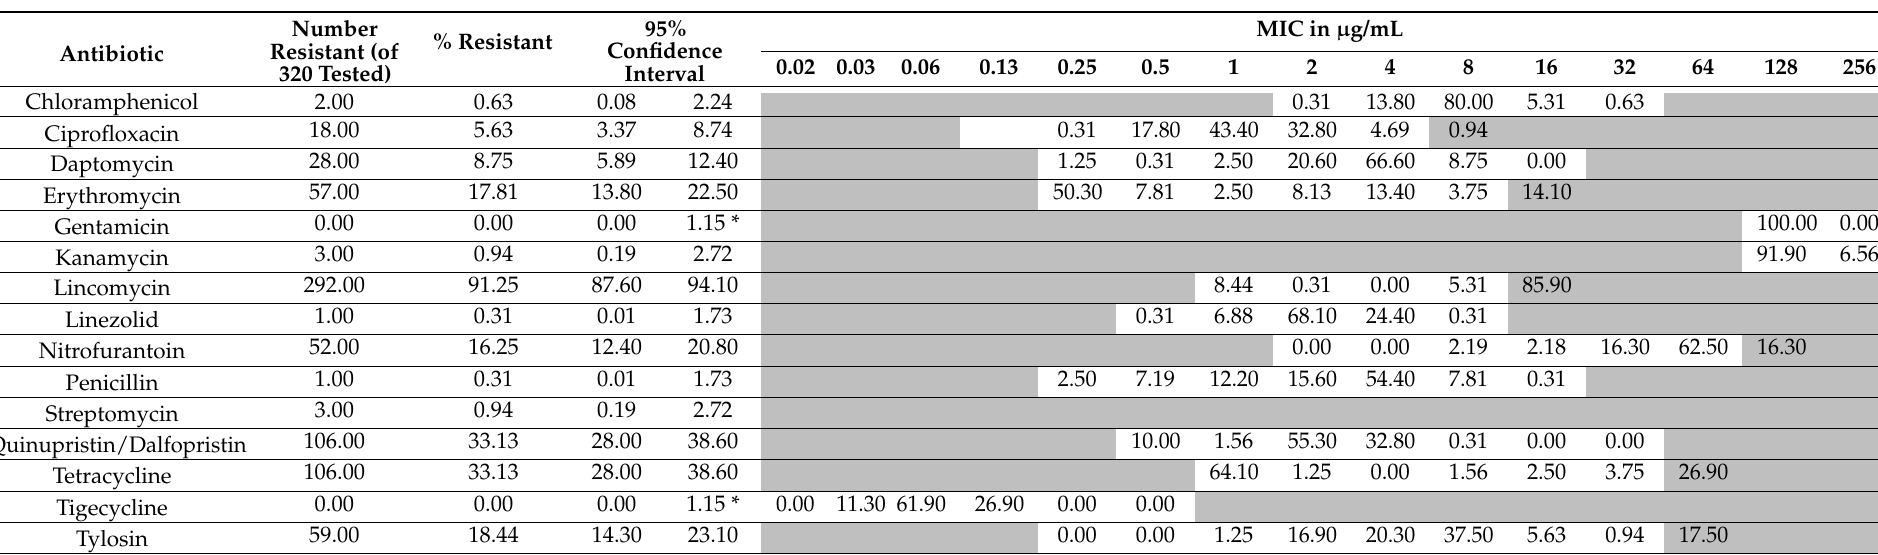
Table 4. Percentage of Enterococcus spp. isolates that were resistant and their distribution across minimum inhibitory concentrations (MIC) for each antibiotic. Black vertical lines indicate the human CLSI (or NARMS) interpretive breakpoint, grey boxes indicate areas above and below highest and lowest limit of assay antibiotic concentrations, respectively. Isolates which exceeded growth at the highest antibiotic concentration were placed in the next MIC